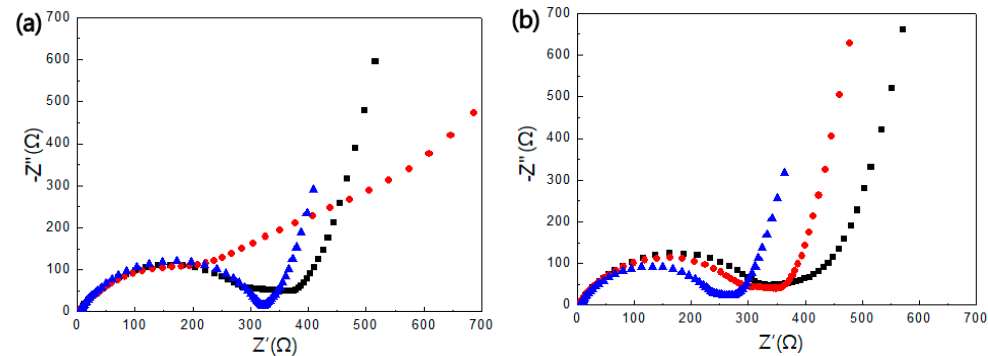
Figure 11. Nyquist impedance plots of the Sn, Sn/TiNi, and TiNi(RT)/Sn/TiNi electrodes after ( a ) first discharge and ( b ) 20th discharge at 0.5 C, measured in the frequency range from 0.01 Hz to 1 MHz. Z’: real part of impedance; Z”: imaginary part of impedance.